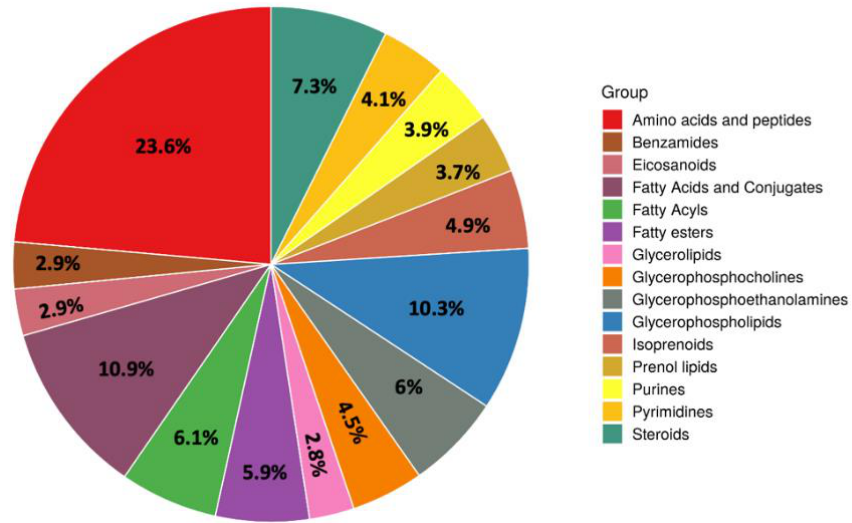
Figure 1. Pie chart showing the chemical classes annotated by untargeted metabolomics in the different milk samples considering those metabolite sits containing at least two entries.